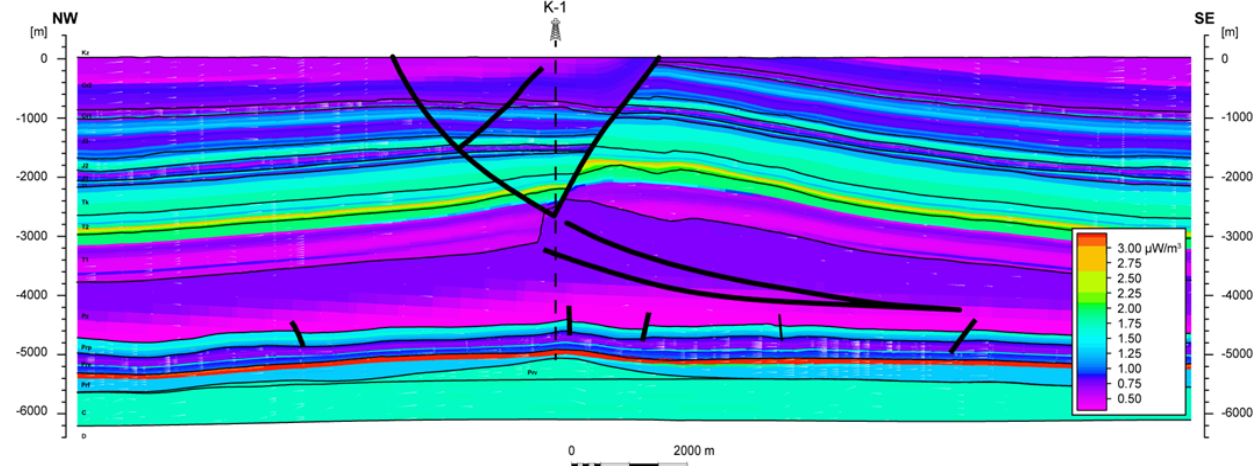
Figure 16. Distribution of the radiogenic heat production along the NW–SE cross ‐ section (SMV2).